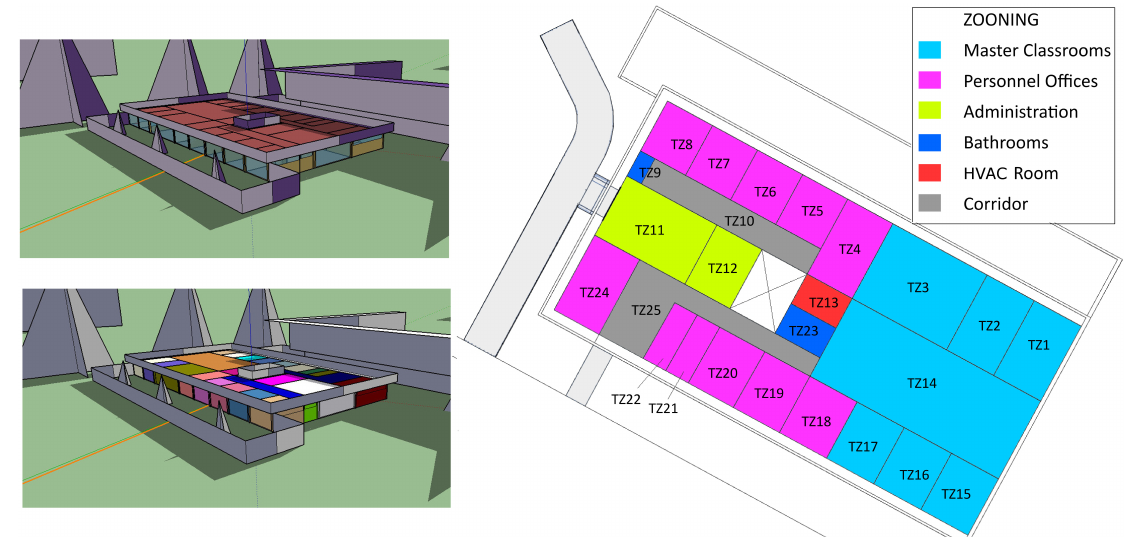
Figure 4. OpenStudio model of the office building (School of Architecture), University of Navarra. (left upper corner): render by surface type, (left lower corner): render by thermal zone, right: thermal zones and space types in the building energy model.